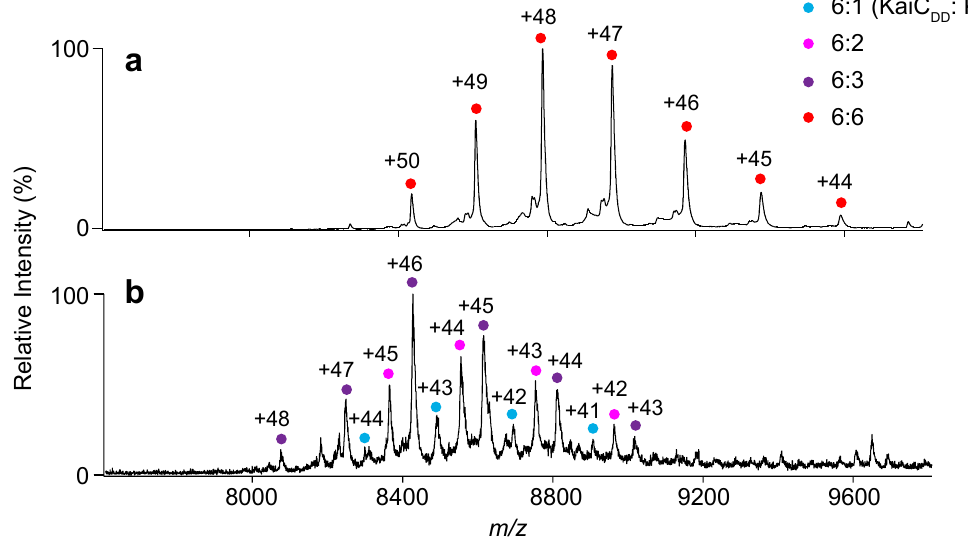
Figure 2. Native MS analysis of KaiB–KaiC complex formation. Mass spectra of mixtures of TeKaiC DD and ( a ) TeKaiB 10–108 or ( b ) TeKaiB 10–108 / DD at a 1:3.5 molar ratio (TeKaiC DD to TeKaiB). The cyan, magenta, purple, and red circles show the ion series of 6:1, 6:2, 6:3, and 6:6 complexes of TeKaiC DD and TeKaiB mutants, respectively.